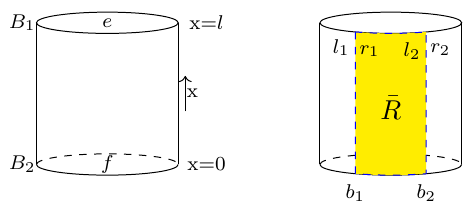
Figure 13 . Entanglement entropy of a strip R on a cylinder, cutting through the top and bottom boundaries. Each of these boundaries are gapped, and is characterized by some